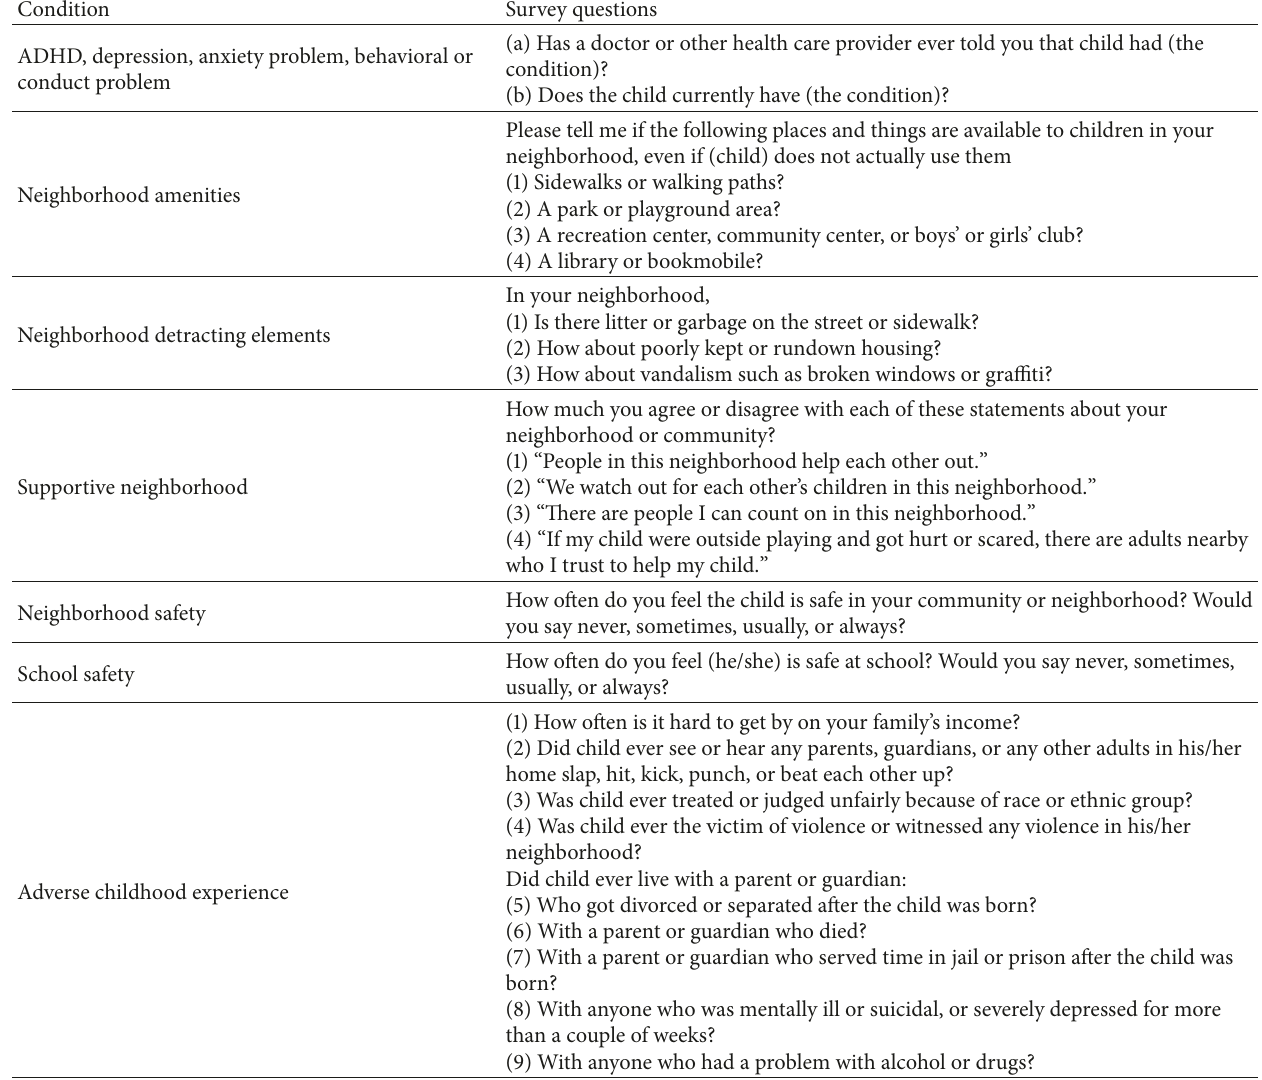
Table 1: Survey questions for different